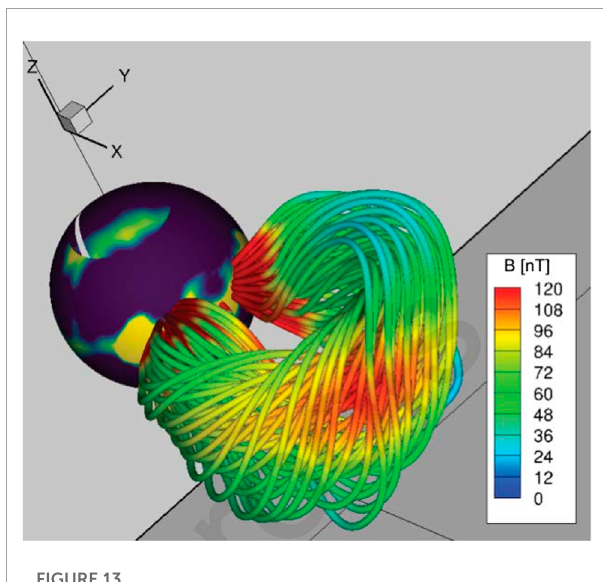
FIGURE 13 FRi3D flux rope emerging out of the EUHFORIA’s inner heliospheric boundary at 0.1 AU (Maharana et al.,